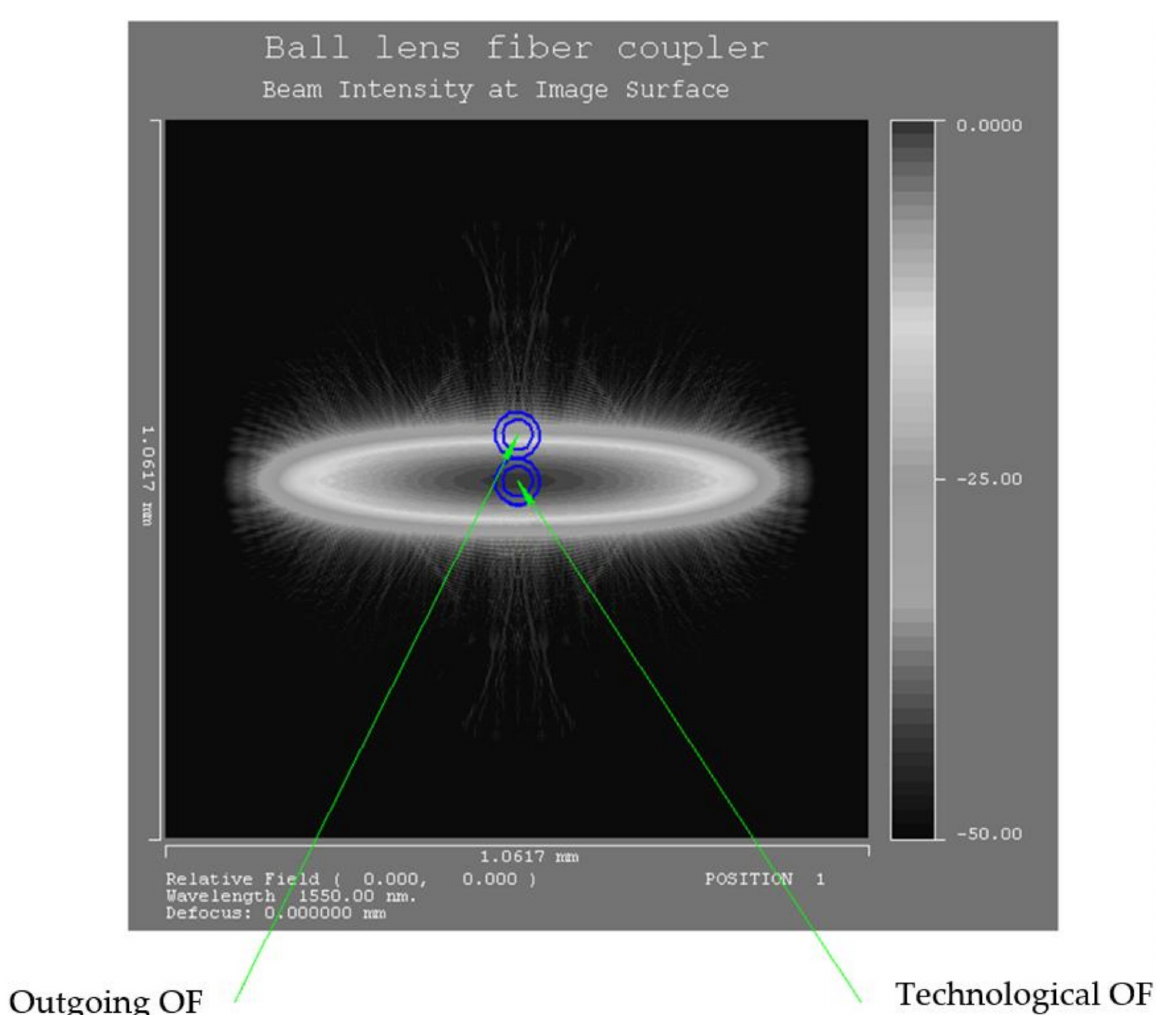
Figure 4. A light spot in the form of an oval, which is formed by two ellipses in the plane of the outgoing optical